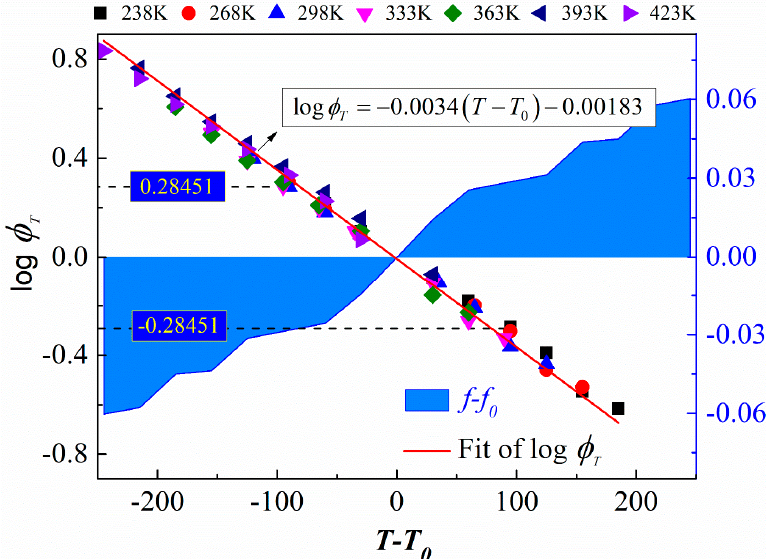
Figure 11. The dependence of the temperature shift factor and fractional free volume on temperature. Colored symbols indicate temperature shift factors at target temperatures of 238, 268, 298, 333, 363, 393, and 423 K. The red curve is the fit of the temperature shift factor. The blue areas are the increments in the fractional free volume with the temperature gradient.